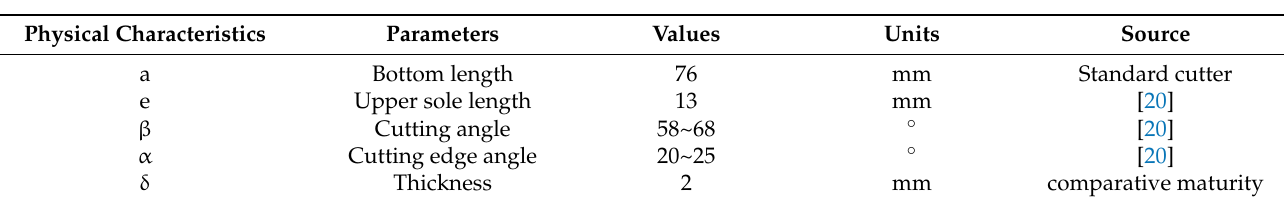
Table 1. Parameters of the moving